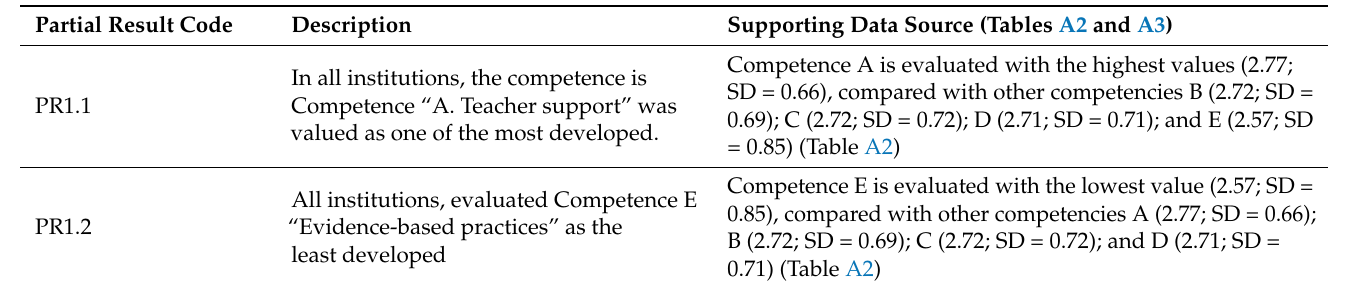
Table A4. Partial results analysis of the data collected through the [Competencies